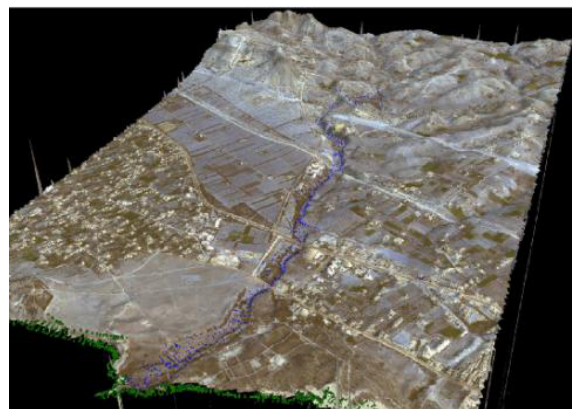
Figure 9. Satellite modelled on the